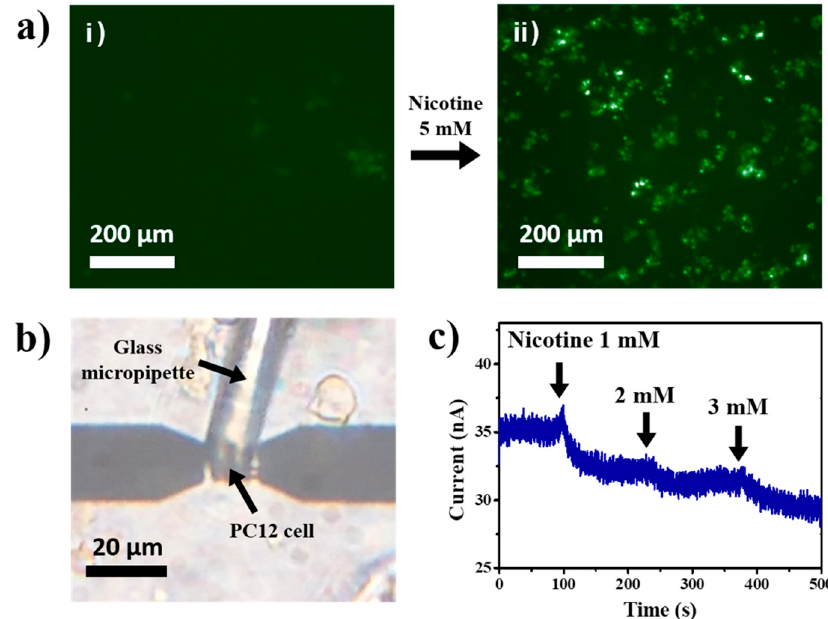
Figure 4. Real-time monitoring of ion-channel activation by nicotine in live cells. ( a ) Fluorescence images of PC12 cells (i) before and (ii) after the stimulation using 5 mM nicotine. The fluorescence occurred after the stimulation. ( b ) Optical image showing a PC12 cell placed on our sensor surface by a glass micropipette, for the electrical monitoring of the cell responses by the stimulation of nicotine. ( c ) Real-time electrical current change of a sensor with PC12 cells during the addition of nicotine solutions as shown in ( b ). The decrease in current was observed after the additions.